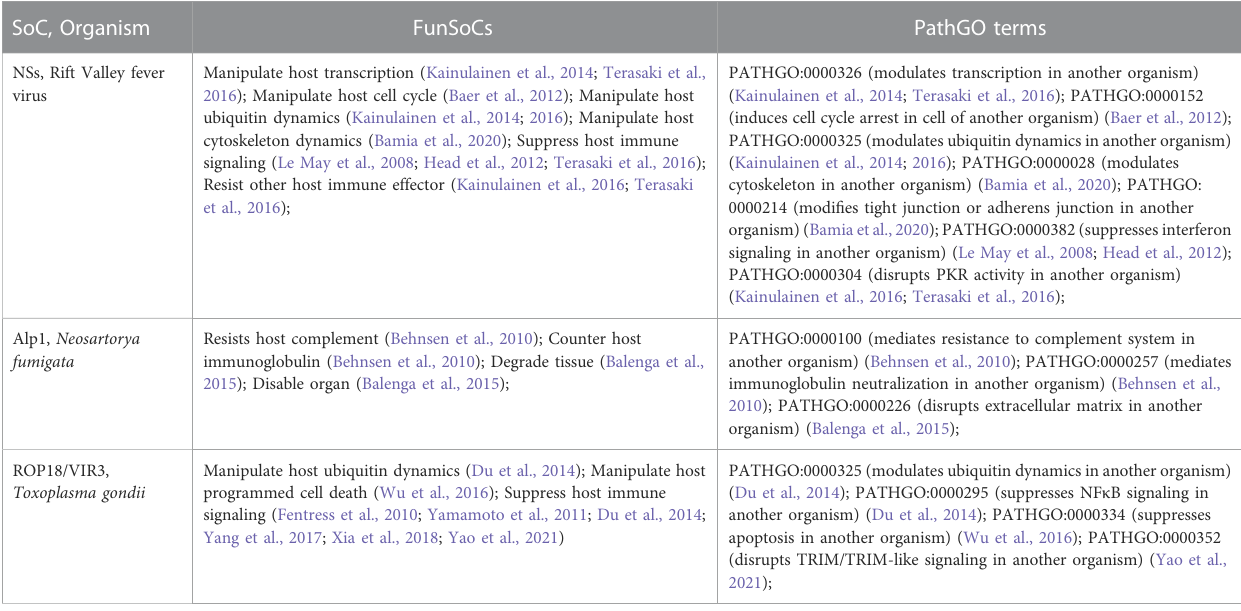
TABLE 5 ( Continued ) SoCs with multiple functions from bacterial, viral, and eukaryotic